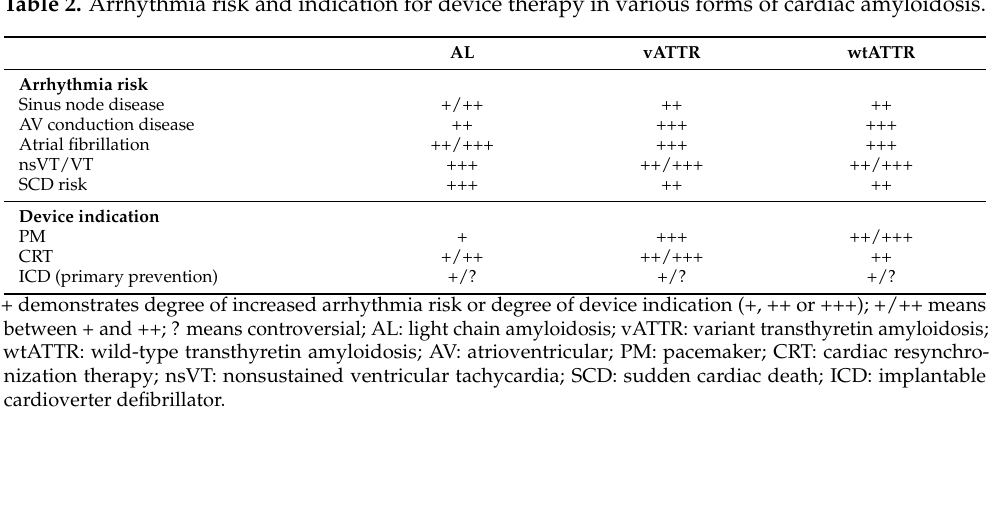
Table 2. Arrhythmia risk and indication for device therapy in various forms of cardiac